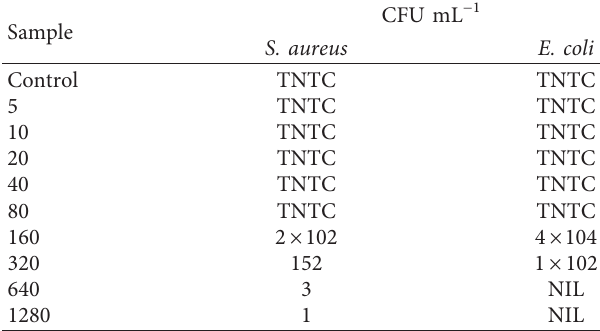
Table 4: Minimum bactericidal activity of polymeric bionano- composite against S. aureus and E. coli .